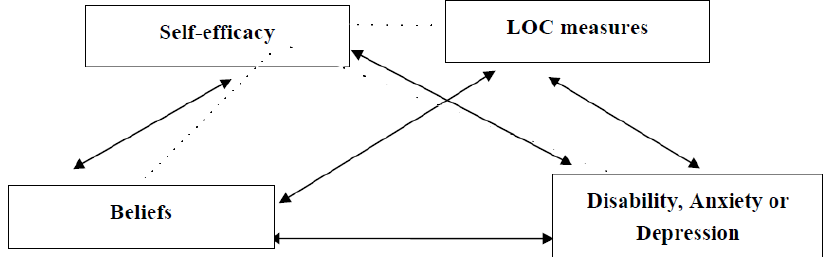
Figure 1. Conceptual Model of Bootstrapped Mediation Model.